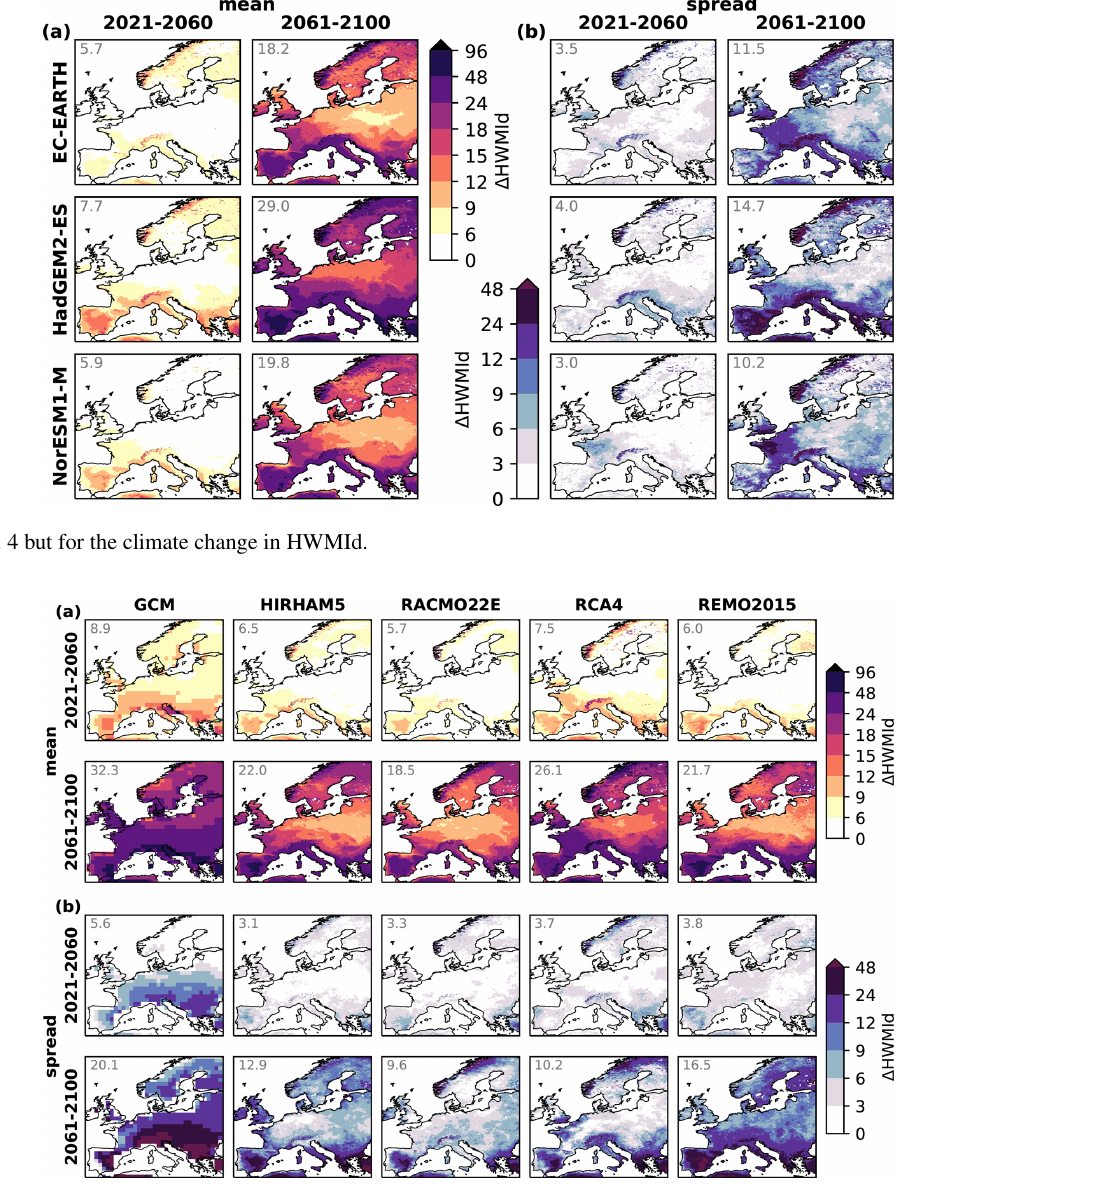
Figure 8. As Fig. 5 but for the climate change in